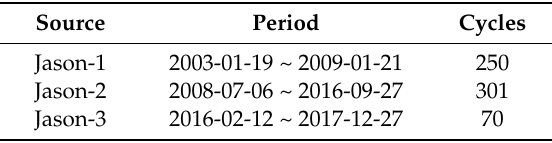
Table 3. Records from the Jason